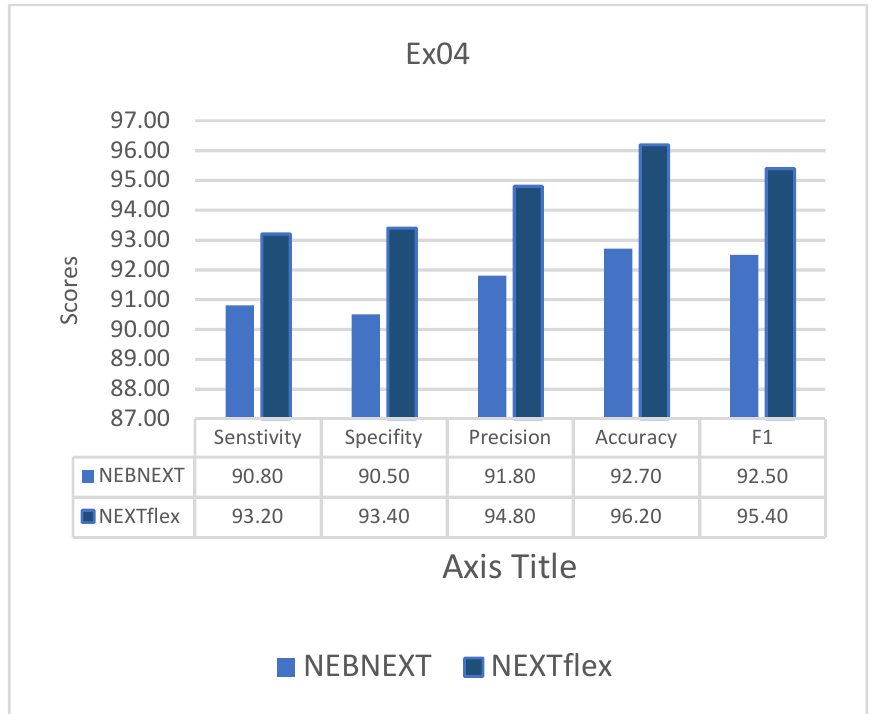
Figure 13. Accuracy scores of biomarker detection of: (a) Applying Model_0 on the samples of Dataset_I prepared by NEBNEXT library (21 samples). (b) Applying Model_0 on the samples of Dataset_I prepared by NEXTflex (21 samples).